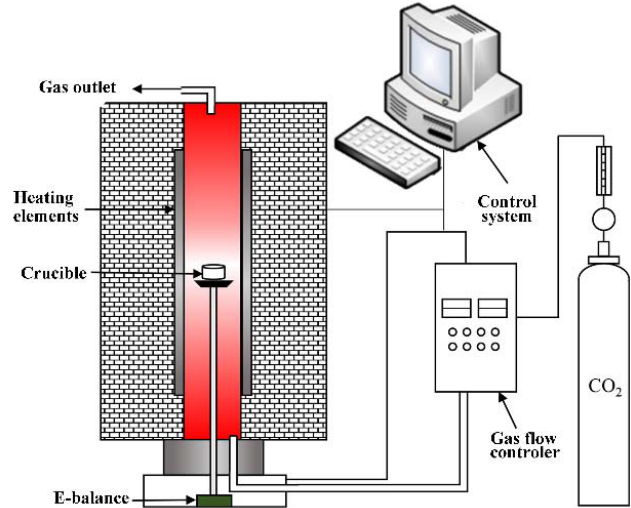
Figure 1. The scheme of the experimental facilities for pyrolysis.